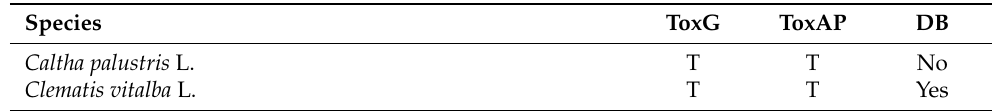
Table 2. List of the 25 species considered harmful by Plants For A Future—PFAF [21]; Species with an indication of toxicity according to Guarrera ( ToxG ) [20] and Acta Plantarum ( ToxAP ) [18];